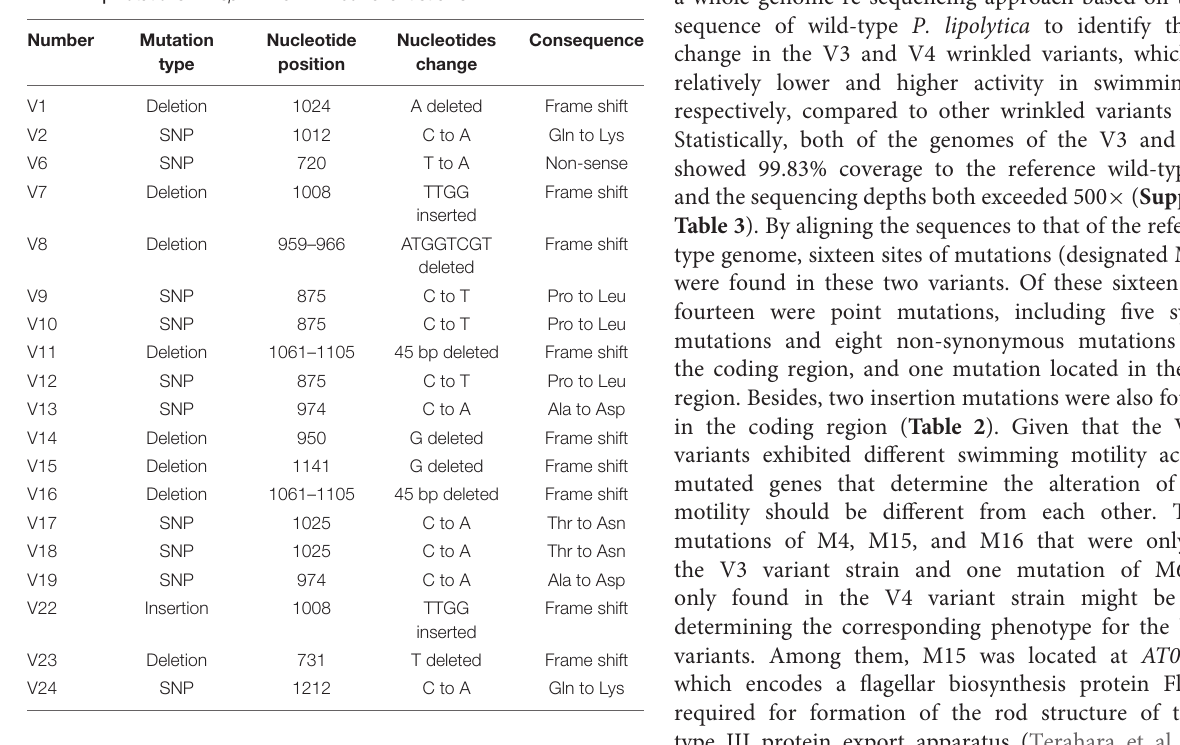
TABLE 1 | Mutations in wspF in 19 wrinkled variant